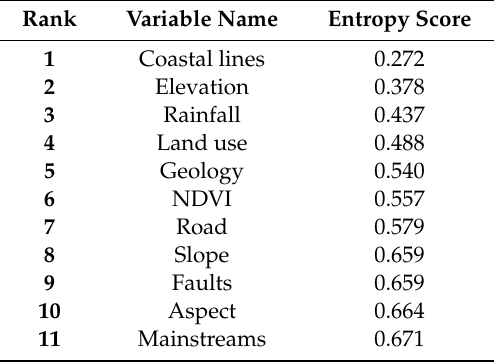
Table 2. Landslide conditioning variables priority rank and the corresponding entropy values.